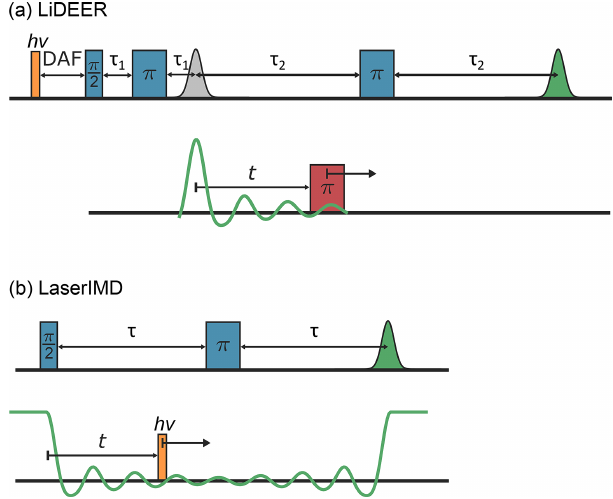
Figure 1. The pulse sequences of (a) LiDEER and (b) LaserIMD. The observed green echoes are modulated when the pump pulse (LiDEER) or laser flash (LaserIMD) is shifted in the time